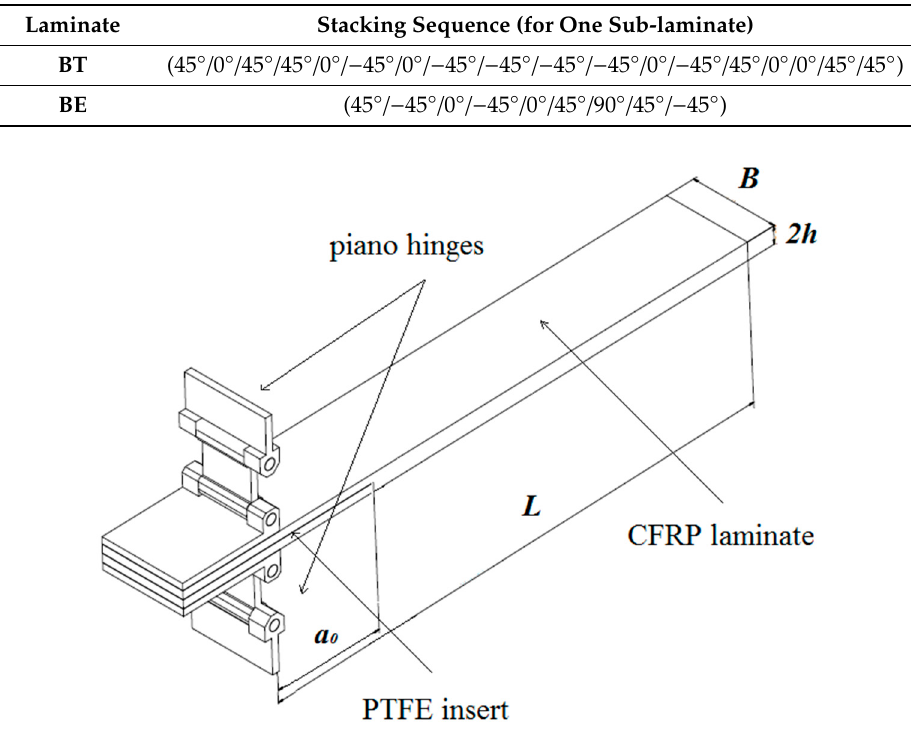
Figure 1. Geometry of the DCB specimen. Table 2. Mechanical properties of carbon / epoxy